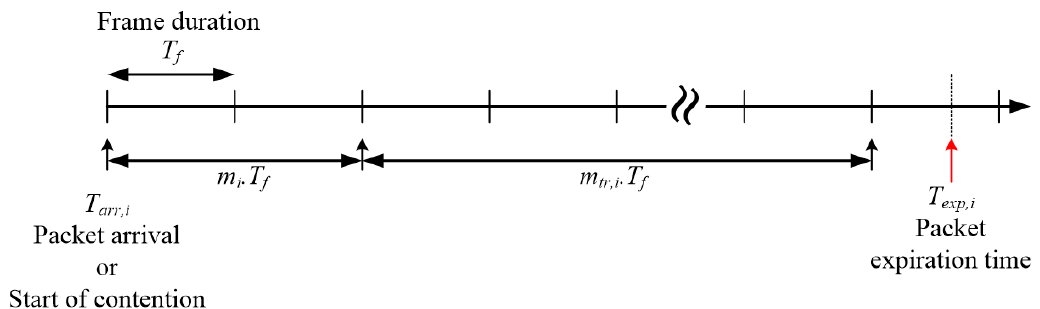
Figure 2. Timeline of the i- th data-ready node requesting channel access and waiting for its turn to transmit.